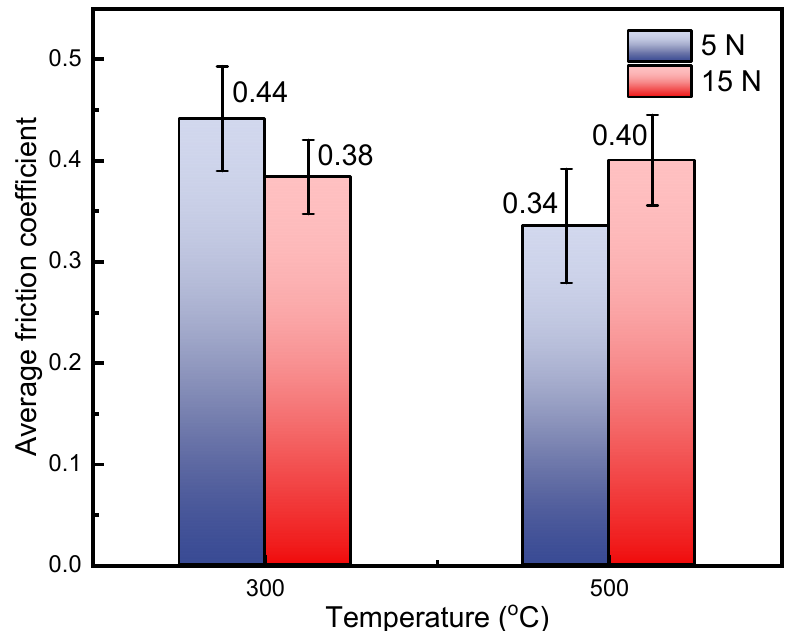
Figure 2. Average friction coefficients of the HNSS under different conditions.